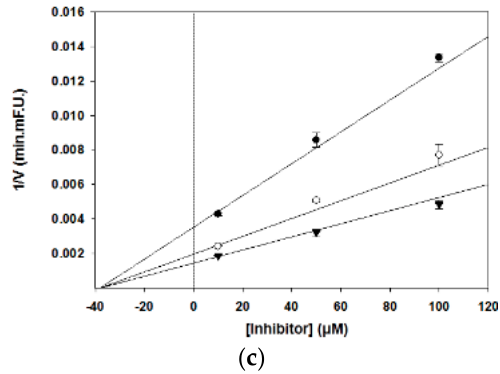
Figure 4. Dixon plot of the reciprocal initial velocities of ( a ) nobiletin, ( b ) tangeretin, and ( c ) sinensetin against BACE1 concentration at several fi xed substrate concentrations: 250 nM ( ● ); 500 nM ( ○ ); 750 nM ( ▼ ).